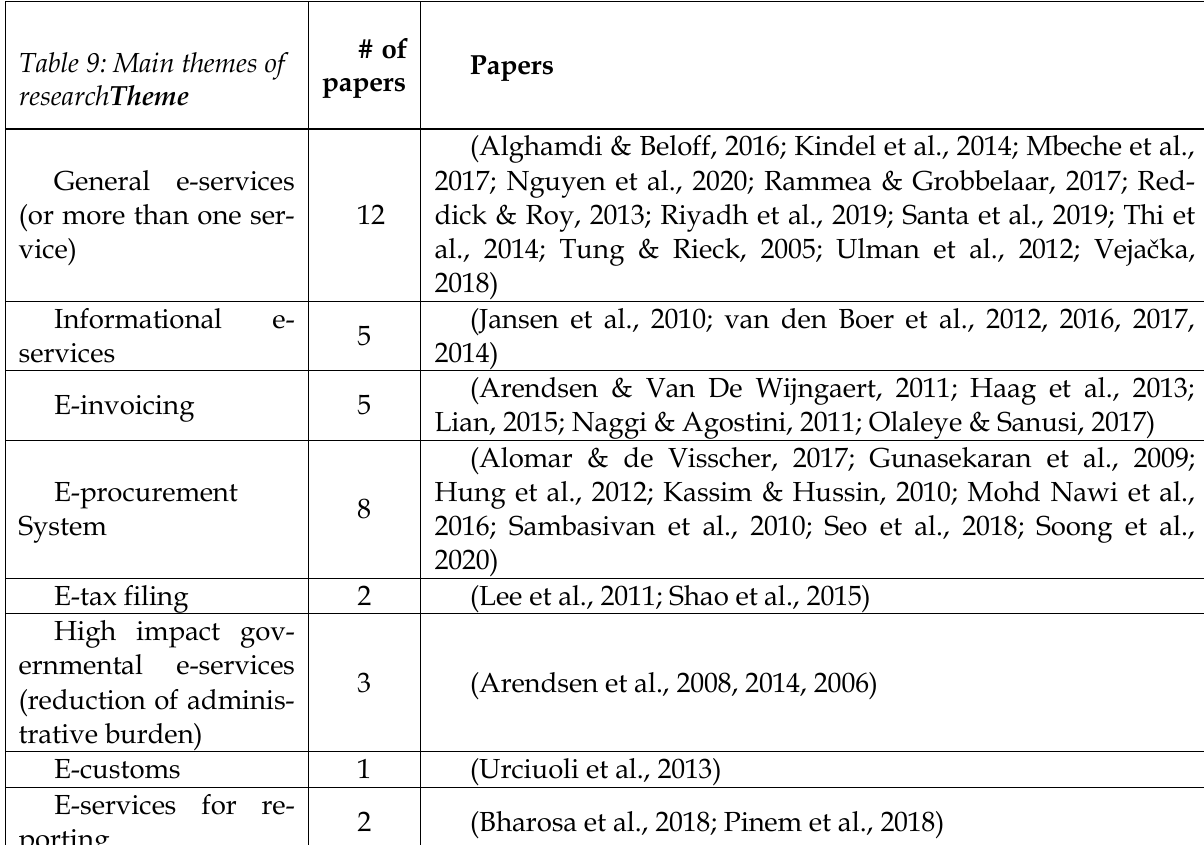
Table 9: Main themes of